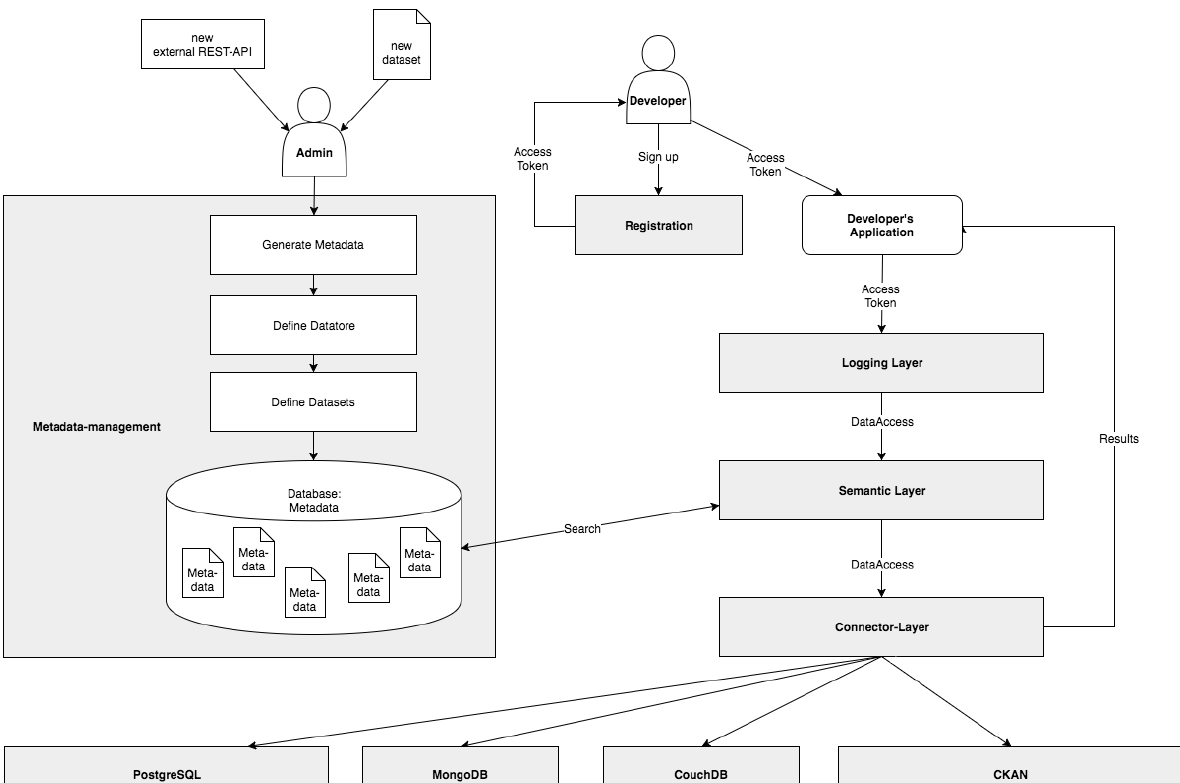
Figure 6: Generic components of a semantic